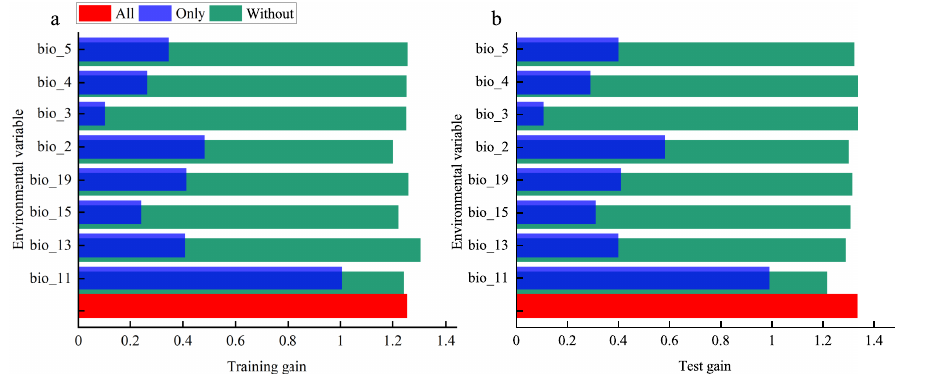
Figure 7. Jackknife tests the importance of the training and test sets of variables to distribution of C. bungei . Panel ( a ) indicates training gain of variables; panel ( b ) indicates test gain of variables. The climate response curve represents the relationship between variables and habitat (Figure 8). Taking the suitable growth probability p > 0.5 as an example, C. bungei is in the best growth condition when the mean temperature of the coldest quarter is − 3.62–